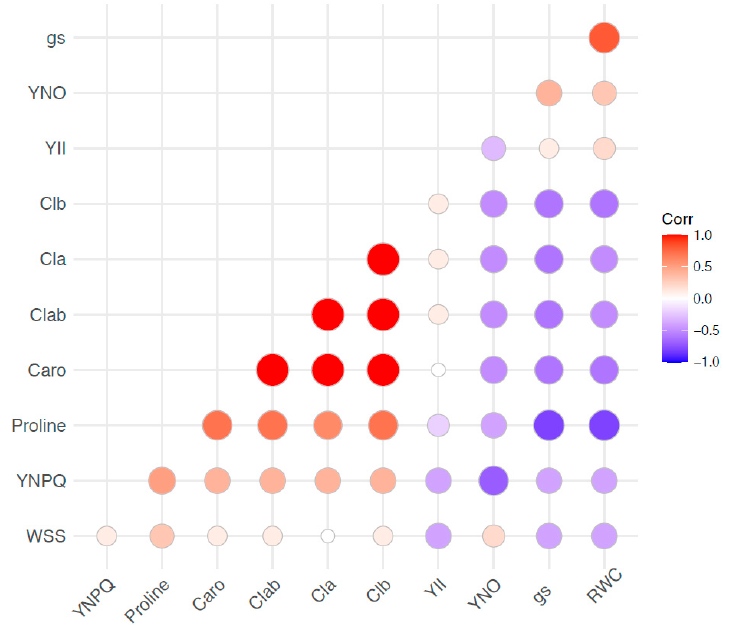
Figure 4. Pearson’s correlation matrix of the physiological and biochemical traits evaluated under water deficit and rehydration. Correlations are displayed based on color intensity (red = positive, blue = negative). Circle size and color intensity are proportional to the correlation coefficient. YNPQ: energy lost by ∆ pH- and zeaxanthin-dependent mechanisms, YII: energy used in photochemistry,